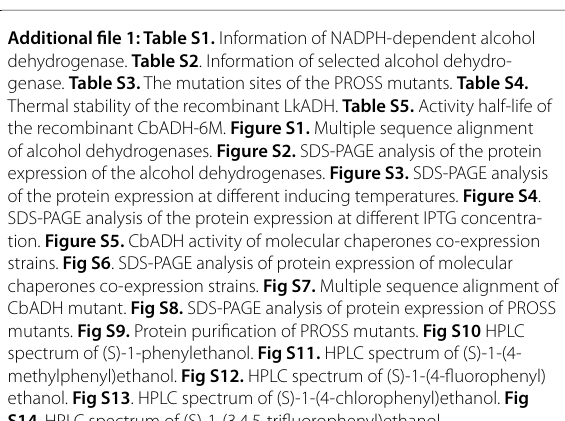
Additional file 1: Table S1. Information of NADPH-dependent alcohol dehydrogenase. Table S2 . Information of selected alcohol dehydro- genase. Table S3. The mutation sites of the PROSS mutants. Table S4. Thermal stability of the recombinant LkADH. Table S5. Activity half-life of the recombinant CbADH-6M. Figure S1. Multiple sequence alignment of alcohol dehydrogenases. Figure S2. SDS-PAGE analysis of the protein expression of the alcohol dehydrogenases. Figure S3. SDS-PAGE analysis of the protein expression at different inducing temperatures. Figure S4 . SDS-PAGE analysis of the protein expression at different IPTG concentra- tion. Figure S5. CbADH activity of molecular chaperones co-expression strains. Fig S6 . SDS-PAGE analysis of protein expression of molecular chaperones co-expression strains. Fig S7. Multiple sequence alignment of CbADH mutant. Fig S8. SDS-PAGE analysis of protein expression of PROSS mutants. Fig S9. Protein purification of PROSS mutants. Fig S10 HPLC spectrum of (S)-1-phenylethanol. Fig S11. HPLC spectrum of (S)-1-(4- methylphenyl)ethanol. Fig S12. HPLC spectrum of (S)-1-(4-fluorophenyl) ethanol. Fig S13 . HPLC spectrum of (S)-1-(4-chlorophenyl)ethanol. Fig S14 . HPLC spectrum of